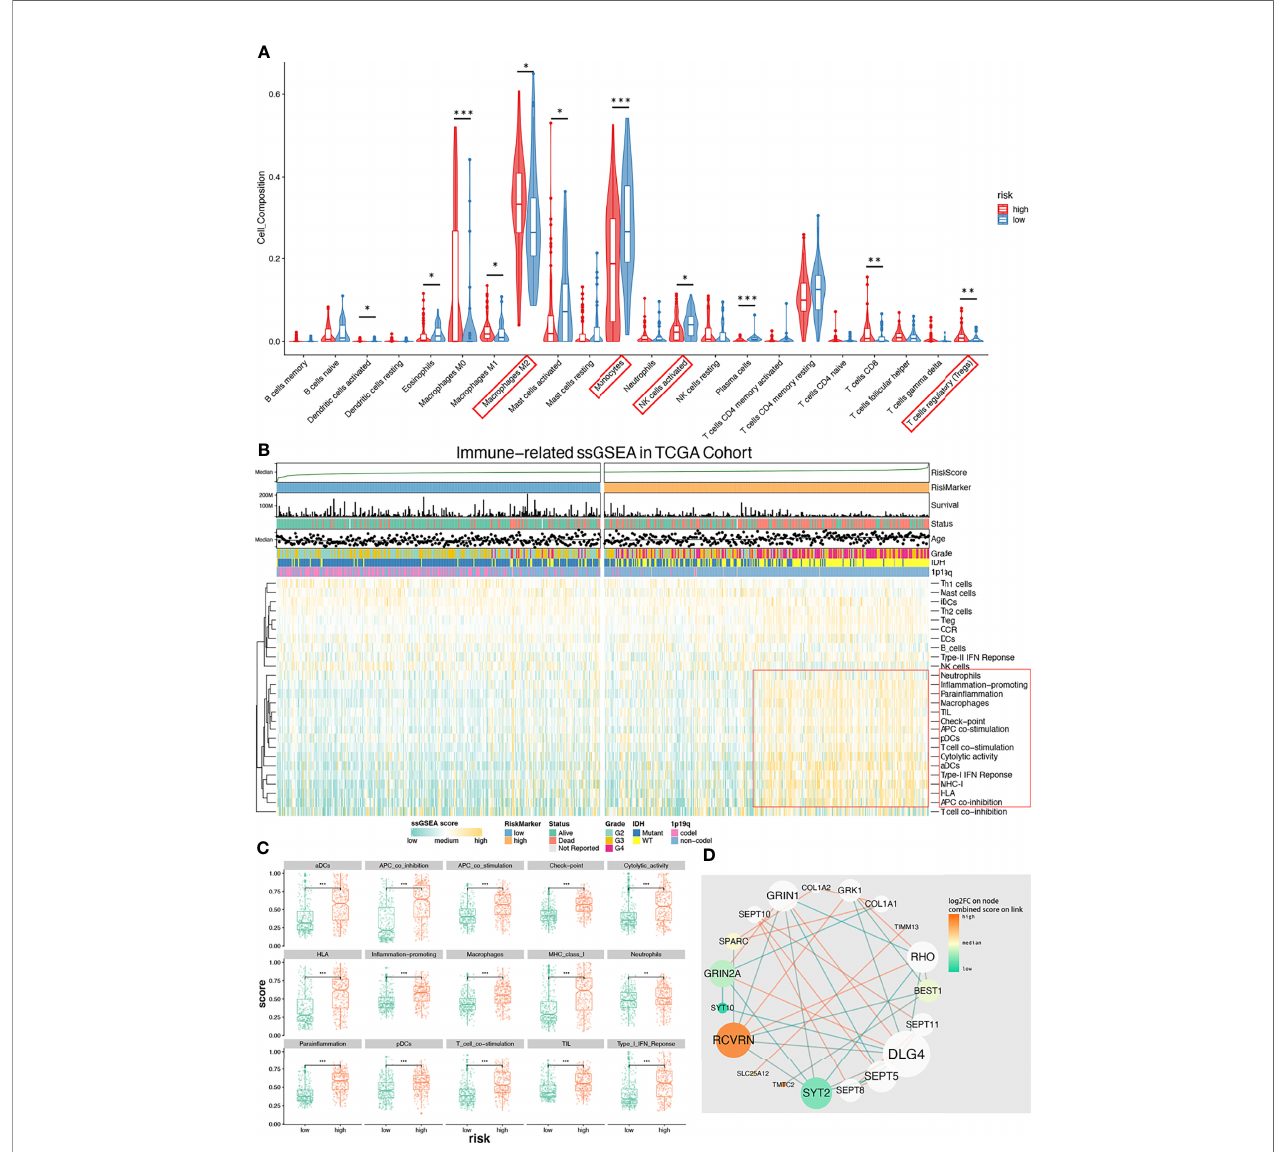
FIGURE 6 | Immune microenvironment with low-/high-risk groups and PPI analysis network of CHGs. (A) Diagram of CIBERSORT result with low-/high-risk group. Immunosuppressive immunocyte (M2, Tregs) is signi fi cantly in fi ltrating in the high-risk group (p < 0.05), and activated NK cells is signi fi cantly in fi ltrating in the low-risk group (p < 0.05). (B) Immune-related ssGSEA heatmap shows that the immunosuppressive gene set (red box) was enriched in the high-risk group. (C) ssGSEA- enriched terms with low-/high-risk groups. (D) The PPI analysis of CHBs. This diagram shows that those immune-related terms are signi fi cantly (p < 0.01) enriched in the high-risk group. *p < 0.05, **p < 0.01, ***p <